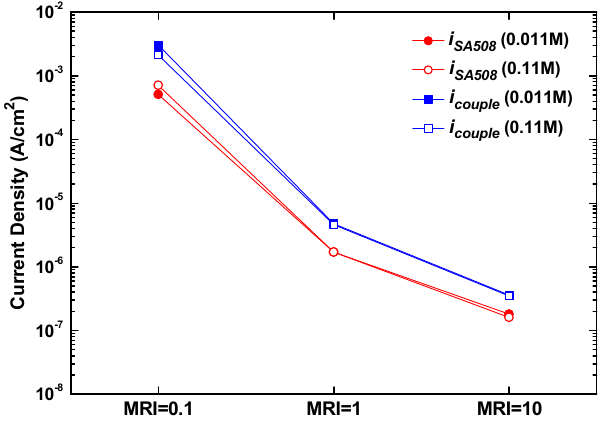
Figure 6. Effect of the MRIs on the galvanic corrosion rate of SA508 coupled to an equal area of Alloy 600.